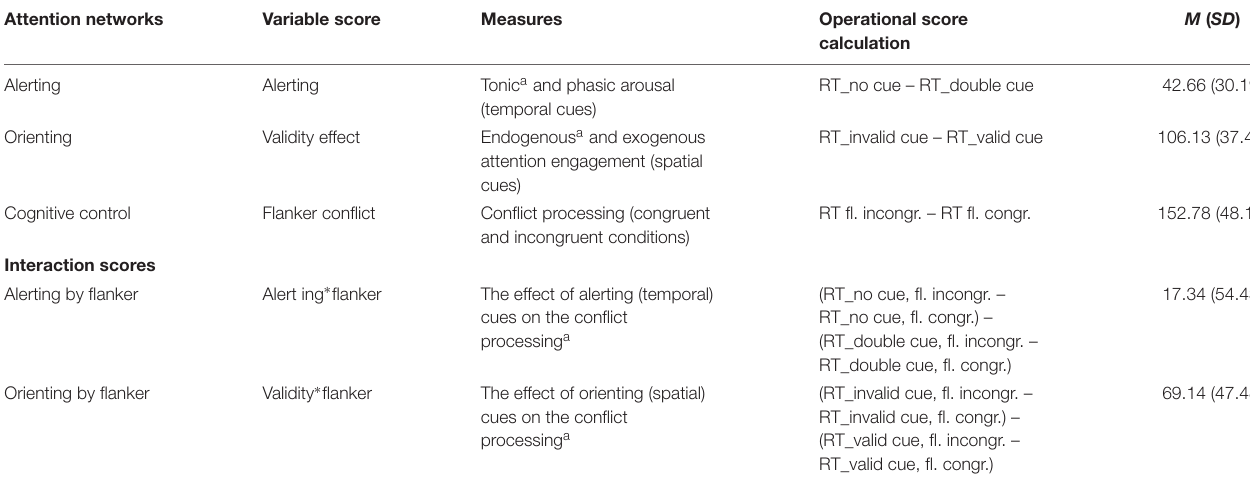
TABLE 1 | Descriptive information about the ANT-R scores.